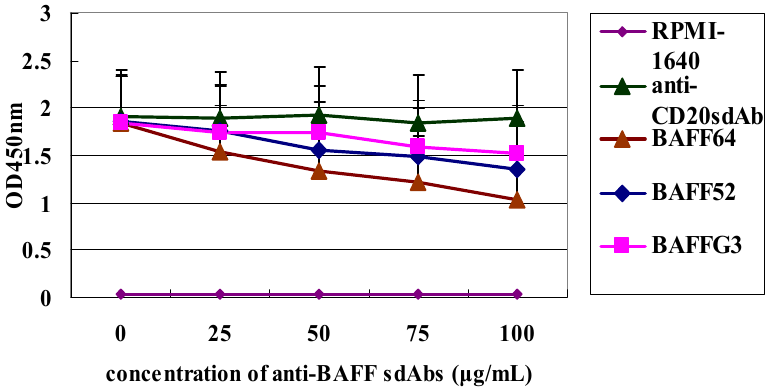
Figure 5. Inhibition of Raji tumor cell proliferation by three sdAbs. Cell viability was assayed by the CCK-8 method. Anti-CD20 sdAb was the negative control. The effects of VHHs on treated Raji cells were presented as the inhibitory ratio compared to the untreated group. The inhibition ratio of BAFF64 (100 μ g/mL) was